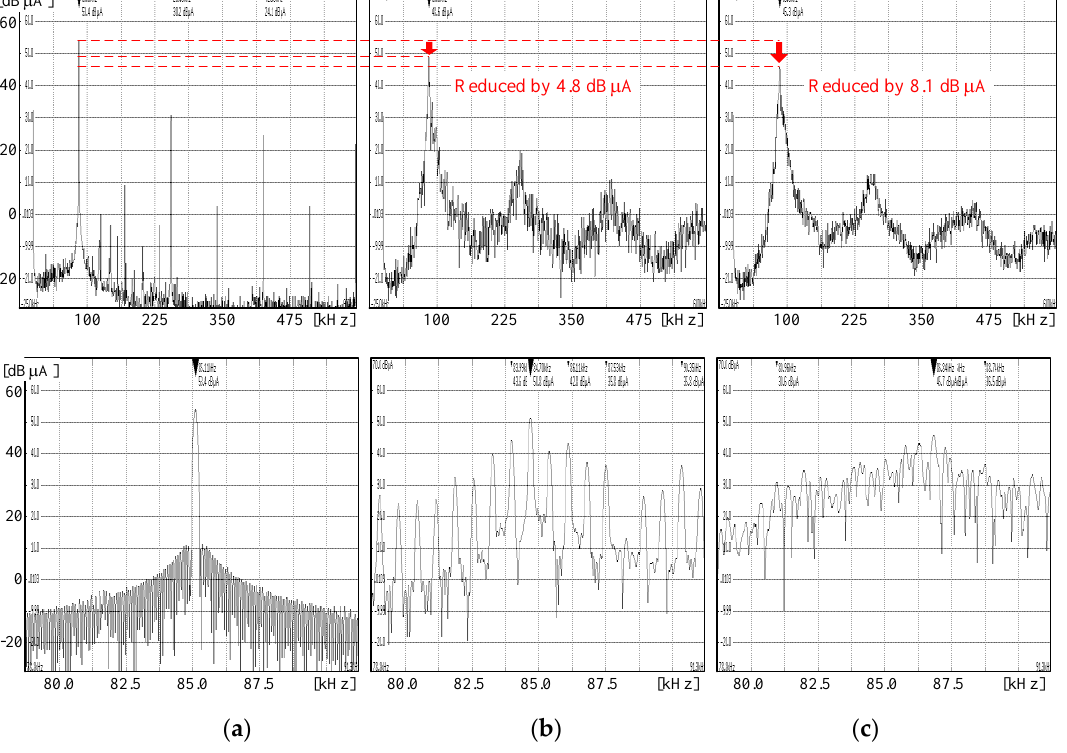
Figure 11. Radiation noise at measurement point A in y-z plane with SP compensation: ( a ) is the conventional method with constant frequency, ( b ) is the proposed method I: SSUD, and ( c ) is the proposed method II: SSBD.